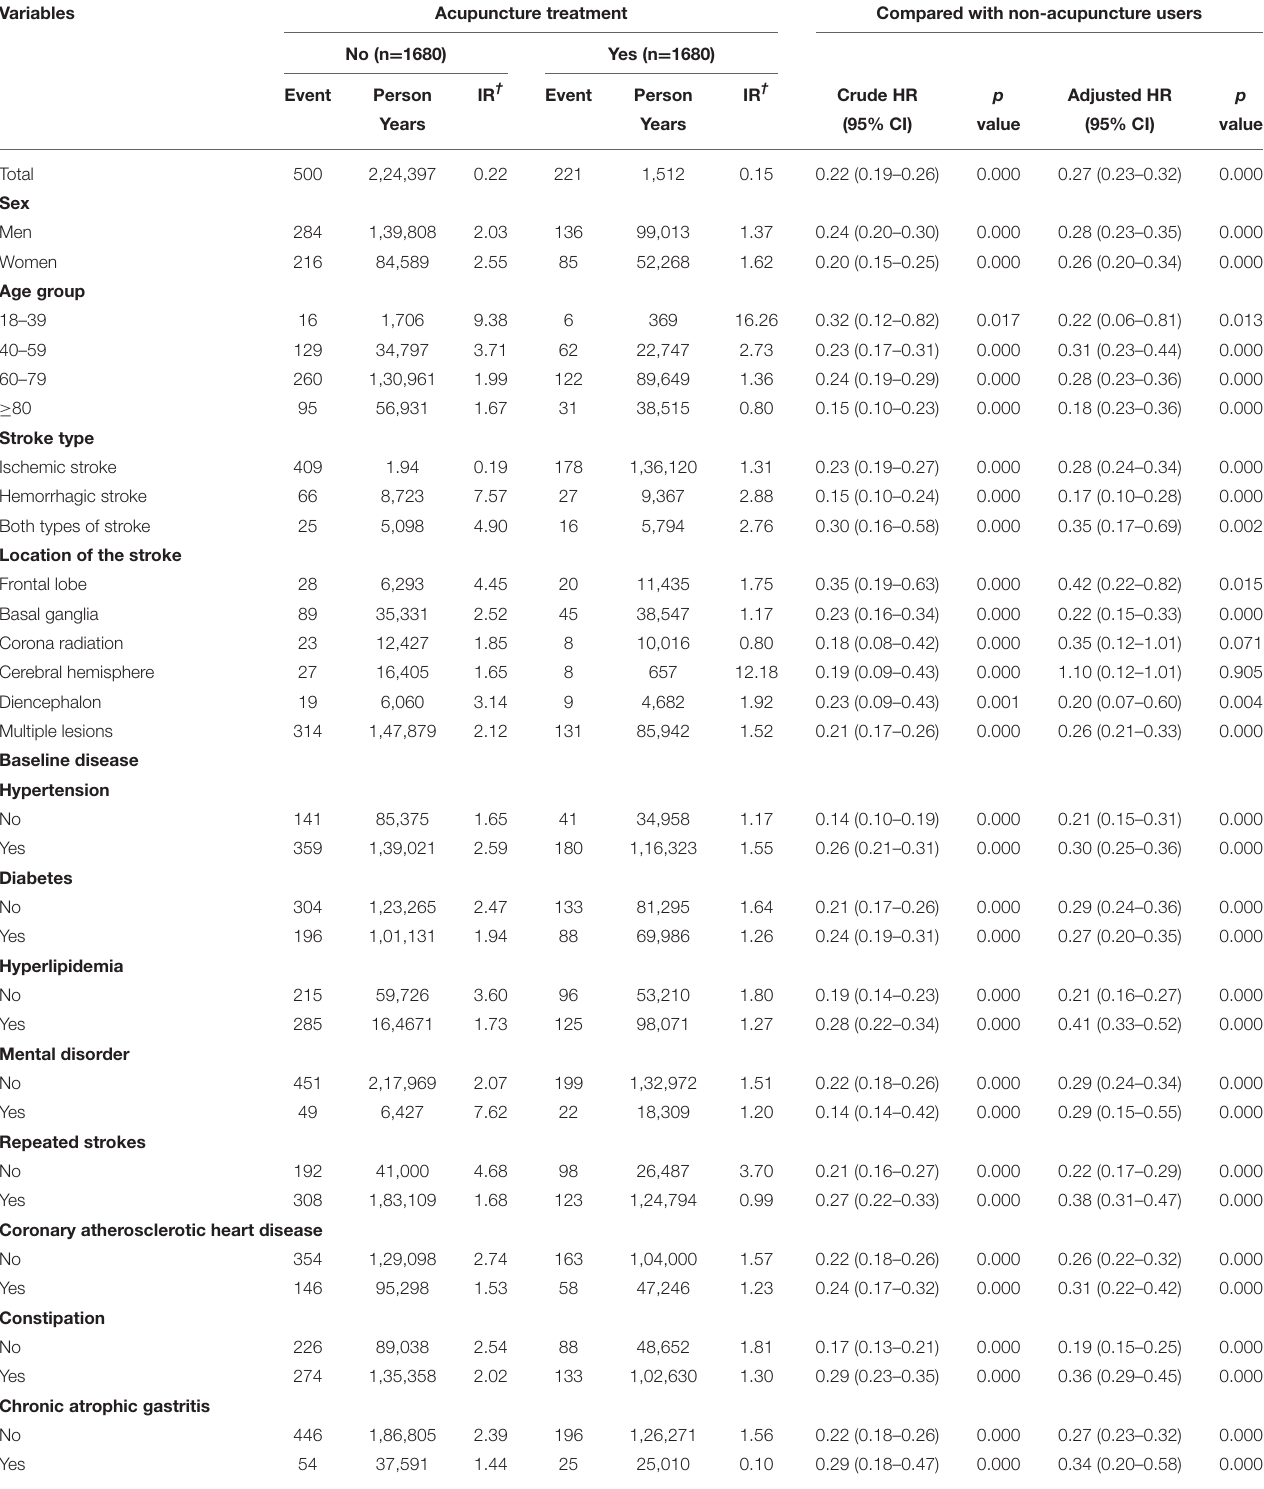
TABLE 3 | The respective hazard ratios and Incidence rates of the acupuncture and non-acupuncture cohorts before and after adjustment for gender, age, stroke type, stroke site, and baseline